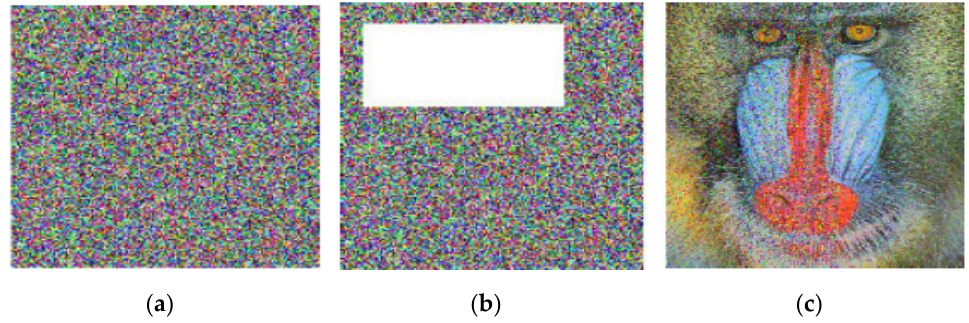
Figure 7. Data loss attack for Baboon image: ( a ) Cipher image; ( b ) Cipher image with a 70 × 180 data loss; ( c ) Decrypted Baboon image from ( b ).